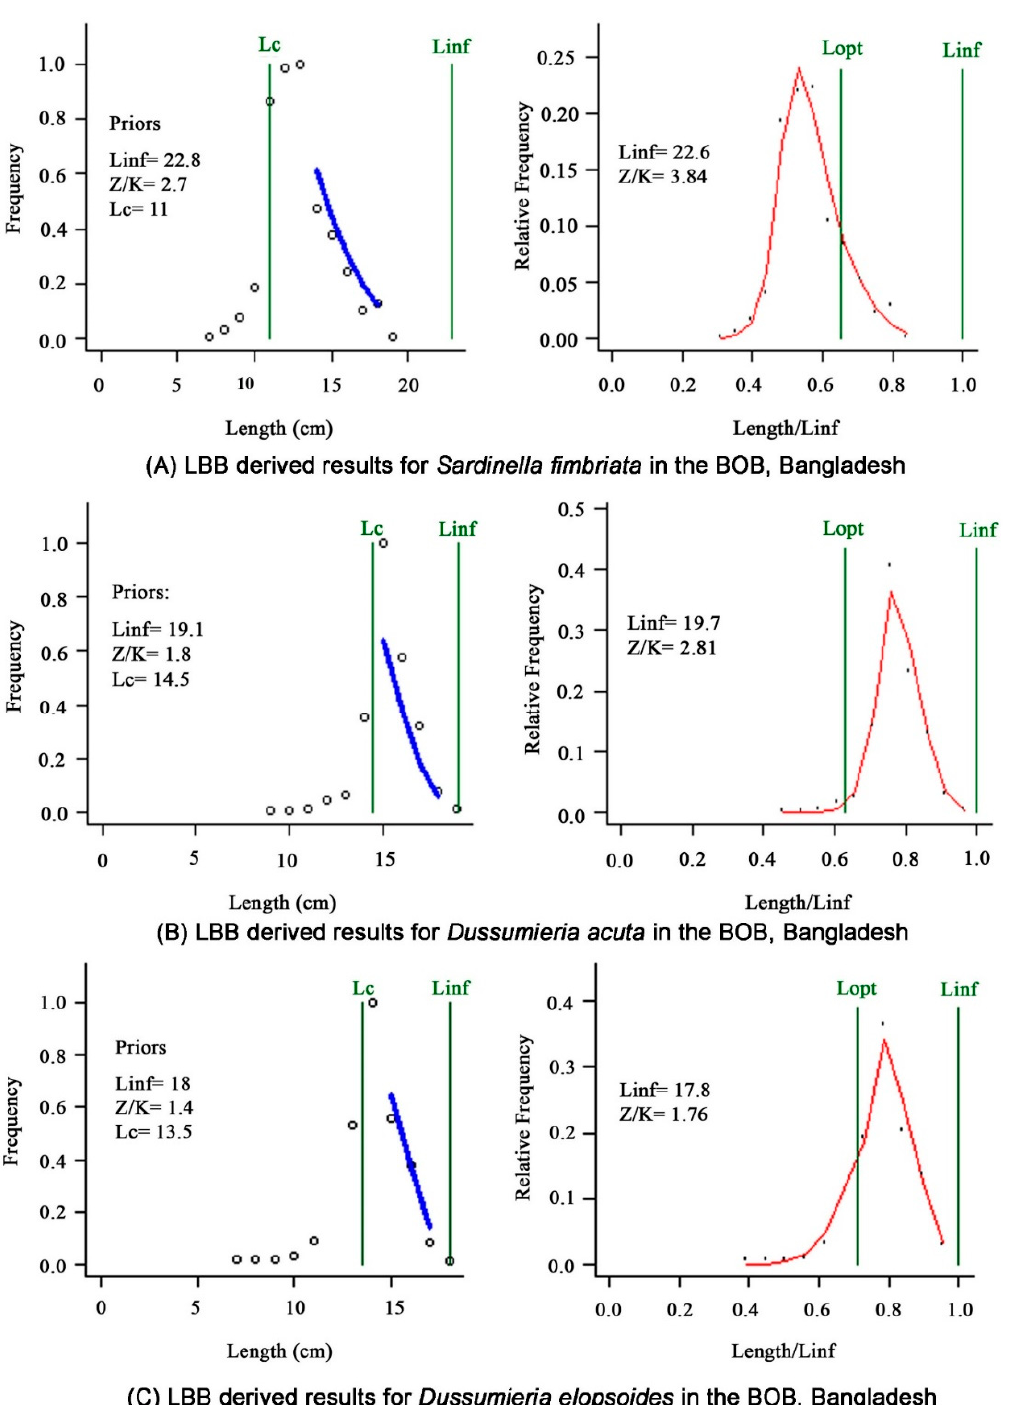
Figure 4. Graphical representation of LBB results for three sardine populations in the BoB, Bangladesh. Left curves depict the LBB model’s fit to the length data, and right curves depict the LBB method’s prediction, where L c denotes the length of 50% of the individuals caught, L inf indicates the body length limit. L opt signifies the length when the maximum catch is achieved.